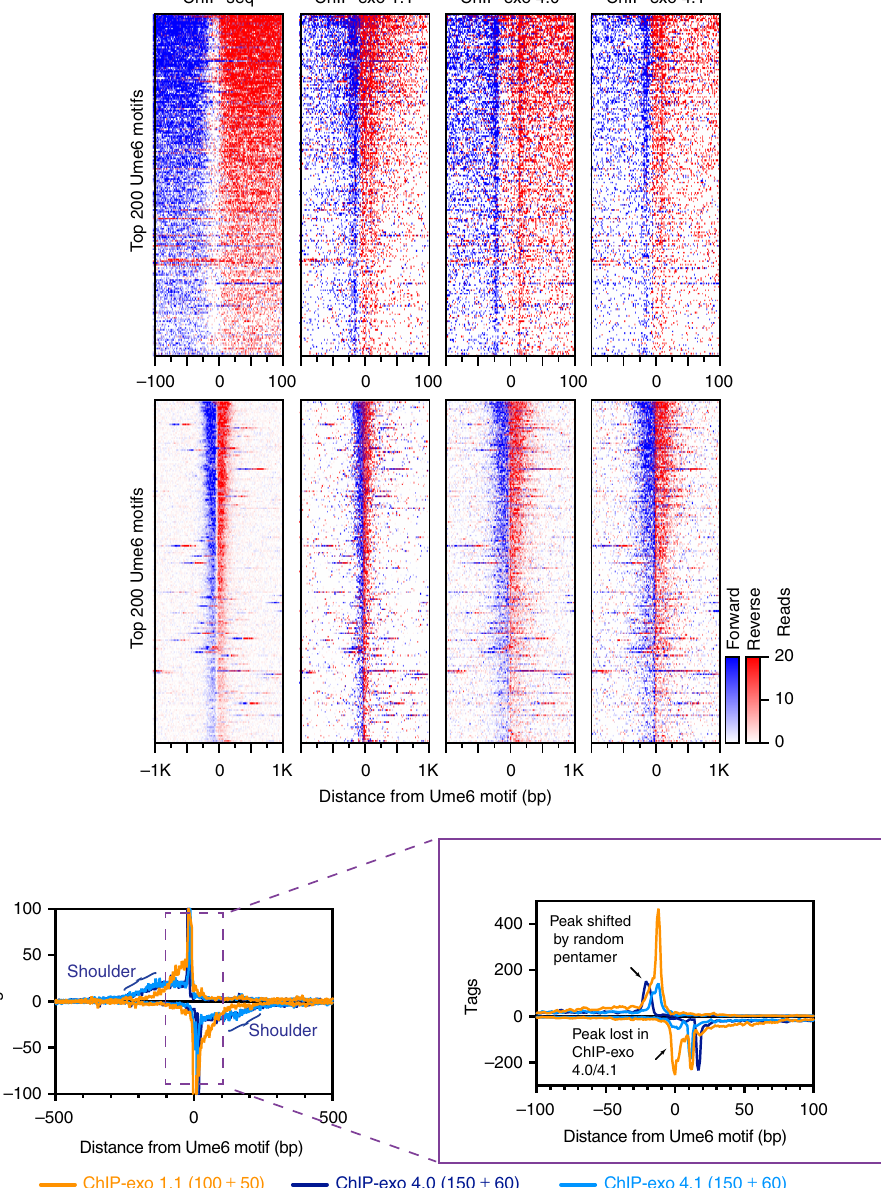
Fig. 3 ChIP-exo 4.0/4.1 display increased shouldering at the binding site compared to version 1.1. a Heatmaps comparing assay versions at the top 200 Ume6 motifs in a 200 bp (top) or 2 kb (bottom) window. b Composite plots of assay versions in a 1 kb window (left) and zoomed to 200 bp (right). The 1 kb window highlights the increased shouldering observed in ChIP-exo 4.0/4.1. The zoomed view highlights that peaks in ChIP-exo 4.0 are shifted 5 bp away from the motif center due to incorporation of the random pentamer; and the peak observed in ChIP-exo 1.1 at the motif midpoint was absent from the ChIP-exo 4.0/4.1